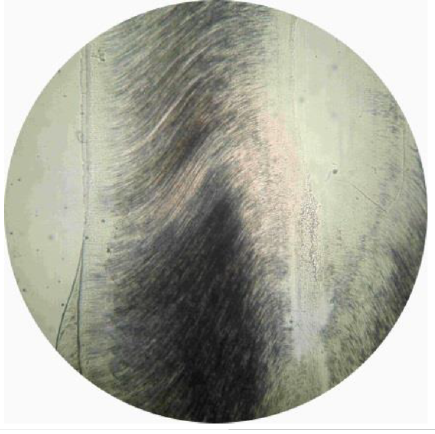
Figure 2. One picture taken with the smartphone mounted on the light